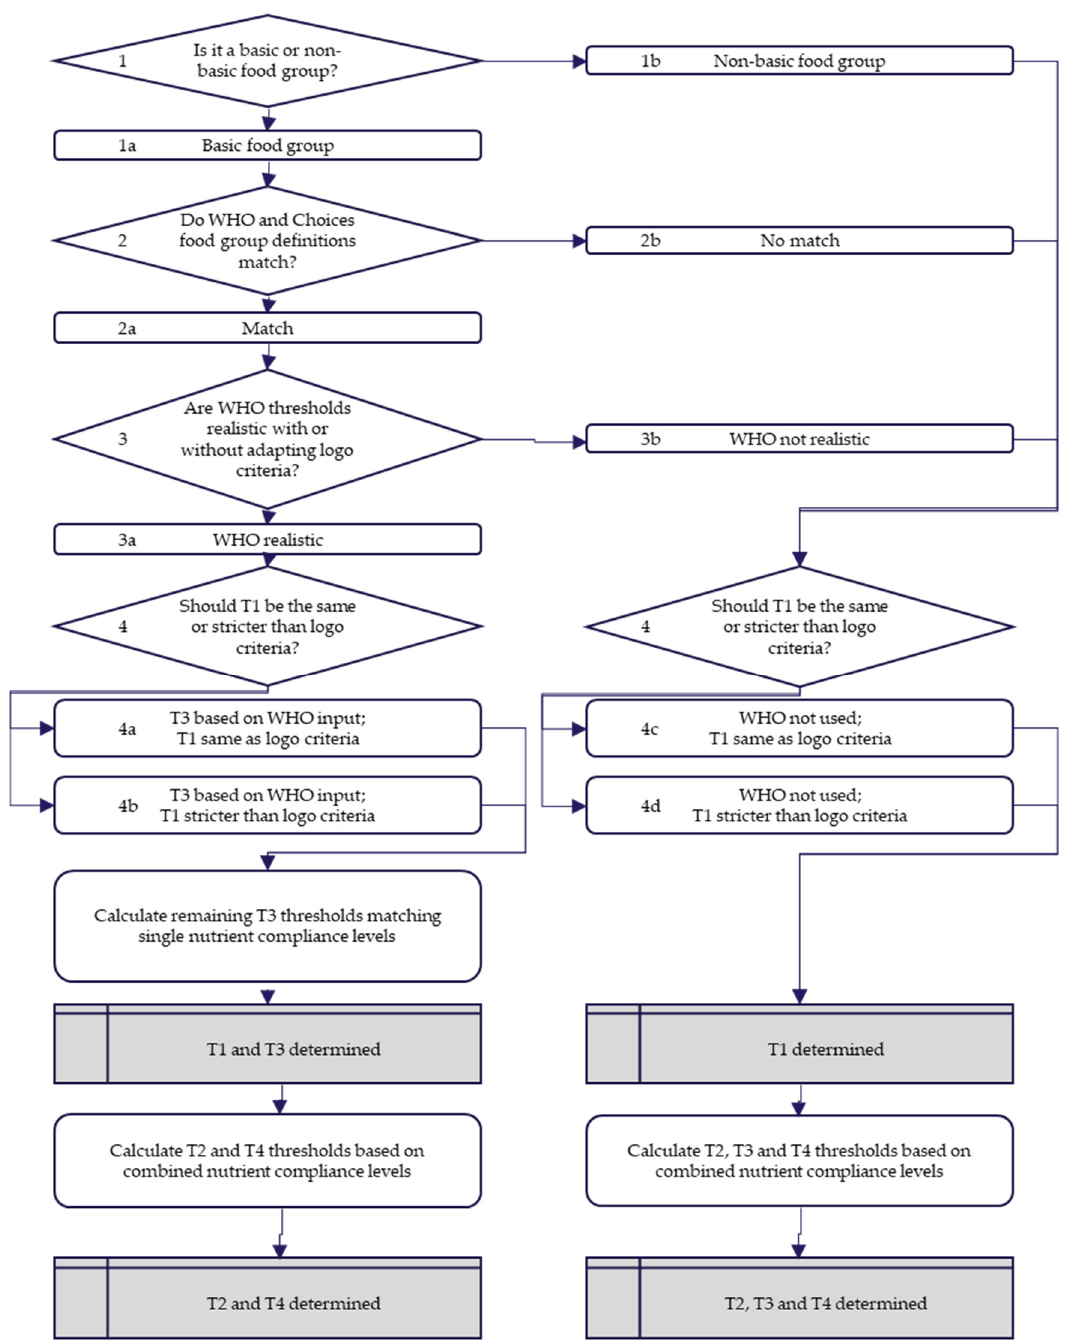
Figure 3. Decision tree describing the process of determining each threshold, T1–T4. The decision of whether the WHO thresholds were considered realistic is taken by assessing compliance levels C1 and C3 of products in the database. This determines at least T1 and, if WHO is used as input for sodium and/or sugar, also these nutrient thresholds for T3. The remaining nutrient thresholds for T3 are then determined by matching single nutrient compliance levels. Finally, T2 and T4, and if WHO was not used, also T3, are determined by interpolation of the combined compliance levels.